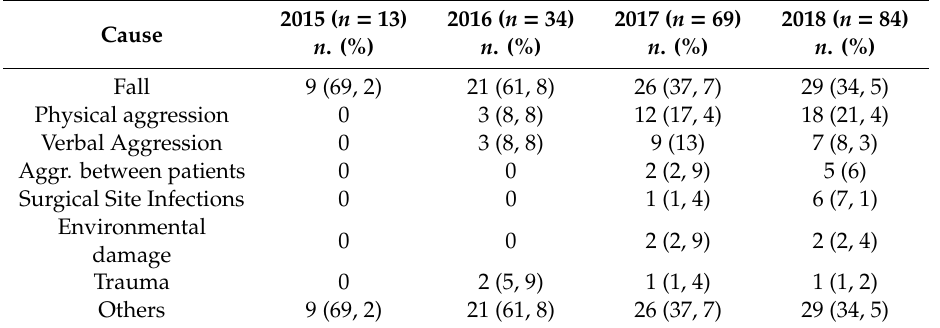
Table 3. Distribution (%) of Incident Reporting records, by reason of event and the reporting year.